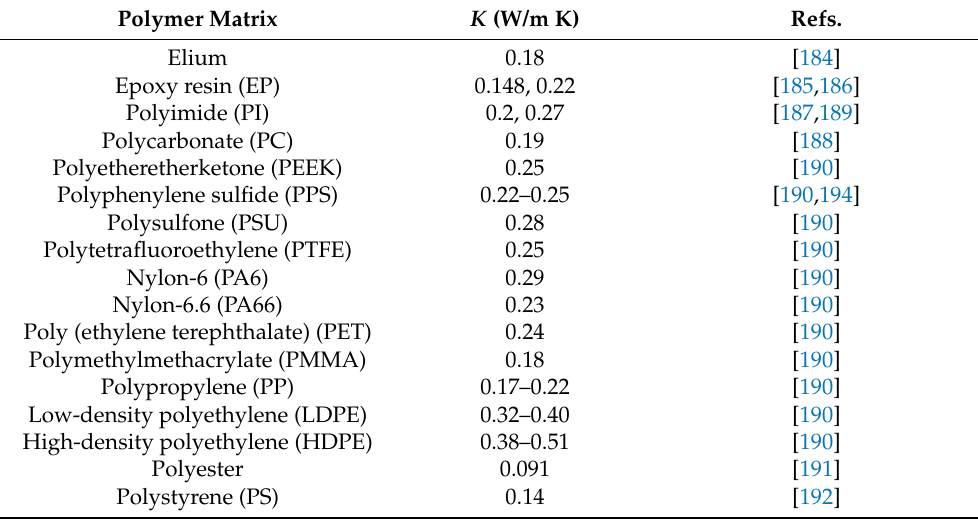
Table 1. Thermal conductivity ( K ) of commonly used polymers.